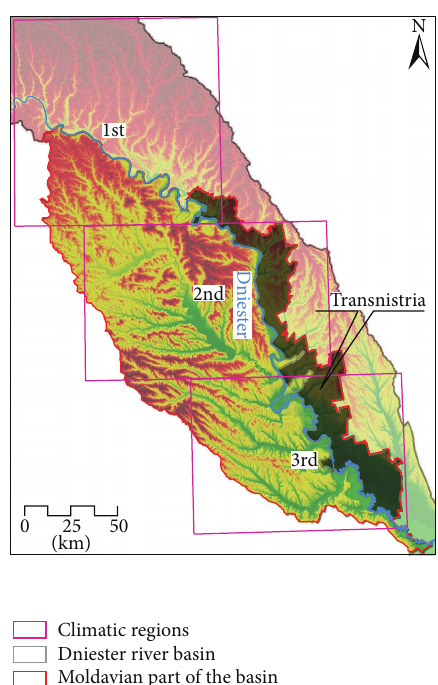
Figure2:Climaticsubregionsforaveragingthebaselineandclimate models’ grid information used for assessment of the basin’s exposure to current and future